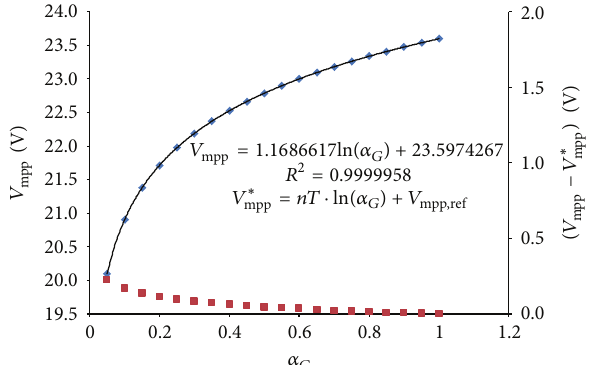
Figure 7: Extrapolation of a logarithmic correlation between 𝑉 and the solar irradiance 𝐺